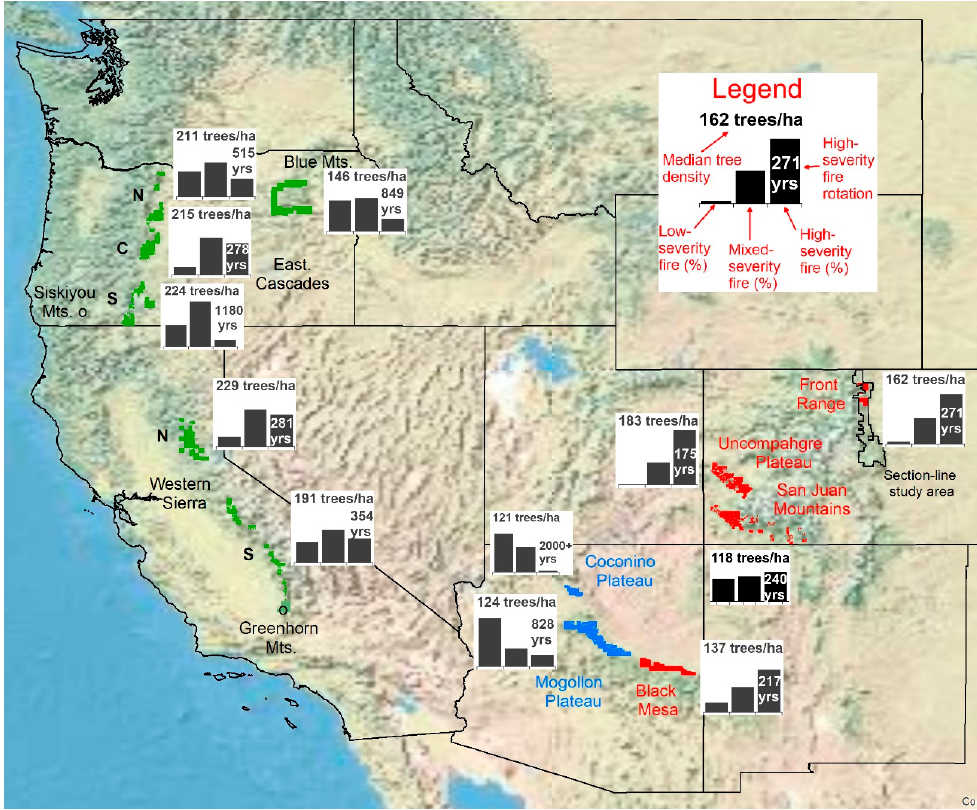
Figure 6. The 15 dry-forest landscapes with reconstructions from U.S. General Land Office survey data based on WB methods. The Greenhorn Mts., CA, and Siskiyou Mts., OR, study areas are small and do not have full reconstructions. The Front Range section-line study area, used in the [31] analysis, is shown by an outline.